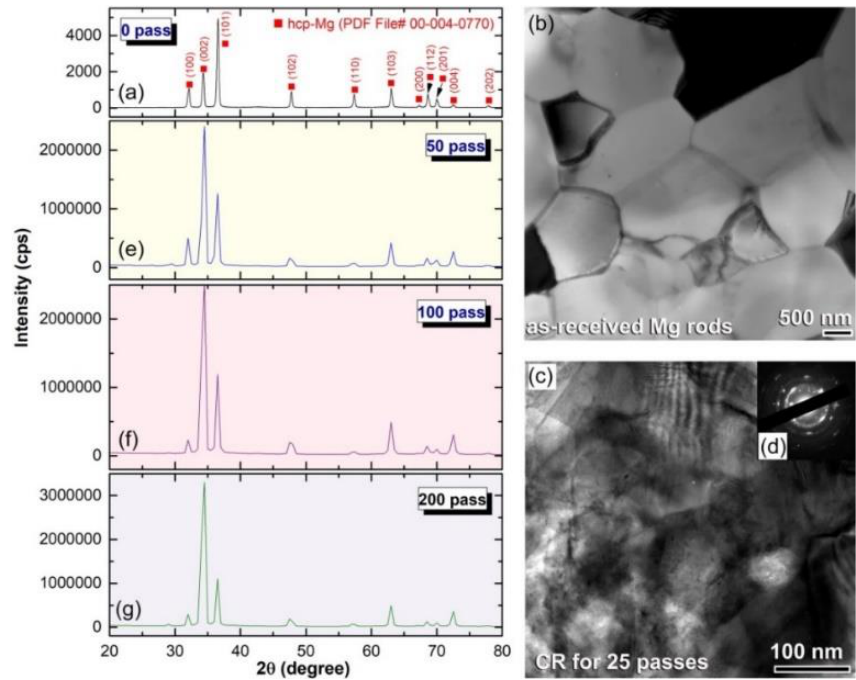
Figure 2. ( a ) XRD pattern and ( b ) the corresponding TEM-BFI of as-received Mg-rods before cold rolling (CR) process. The BFI of the rods obtained after CR for 25 passes is shown together with its related selected area diffraction patterns (SADP) in ( c ) and ( d ), respectively. The XRD patterns of the samples that were CR for 50, 100, and 200 passes are displayed in ( e ), ( f ), and ( g ), respectively. After 25 cycles of CR, these grains tended to disintegrate along their grain boundaries, forming finer grains (75 nm to 190 nm) of polycrystalline Mg, as presented in Figure 2c,d, respectively. Further CR (50–200 passes) resulted in tremendous lattice defects, as shown by the considerable mismatching of the Bragg peaks for crystallographic planes (002) and (101) in Figure 2e,g. This requires the formation of a high level for the fiber texture’s plane (002)